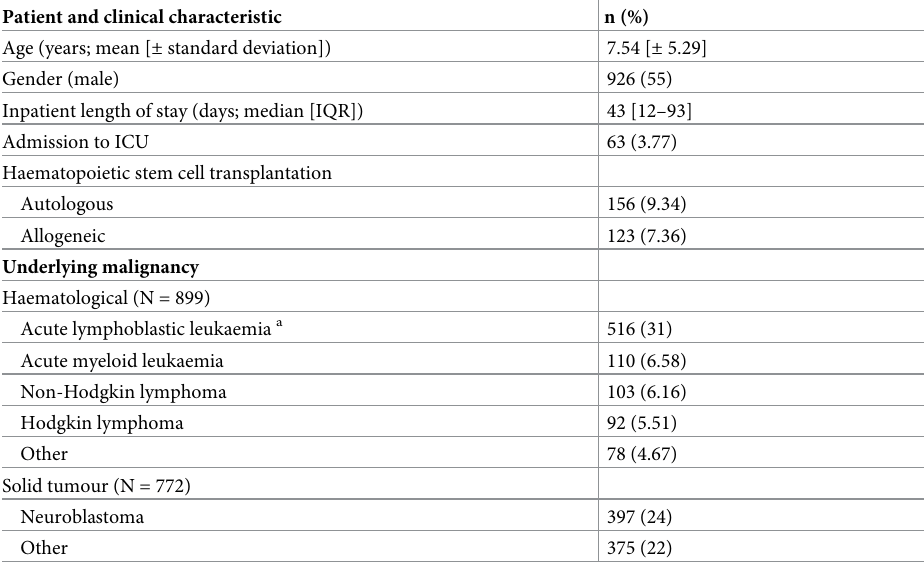
Table 2. Baseline characteristics of the study cohort, N = 1,671. Patient and clinical